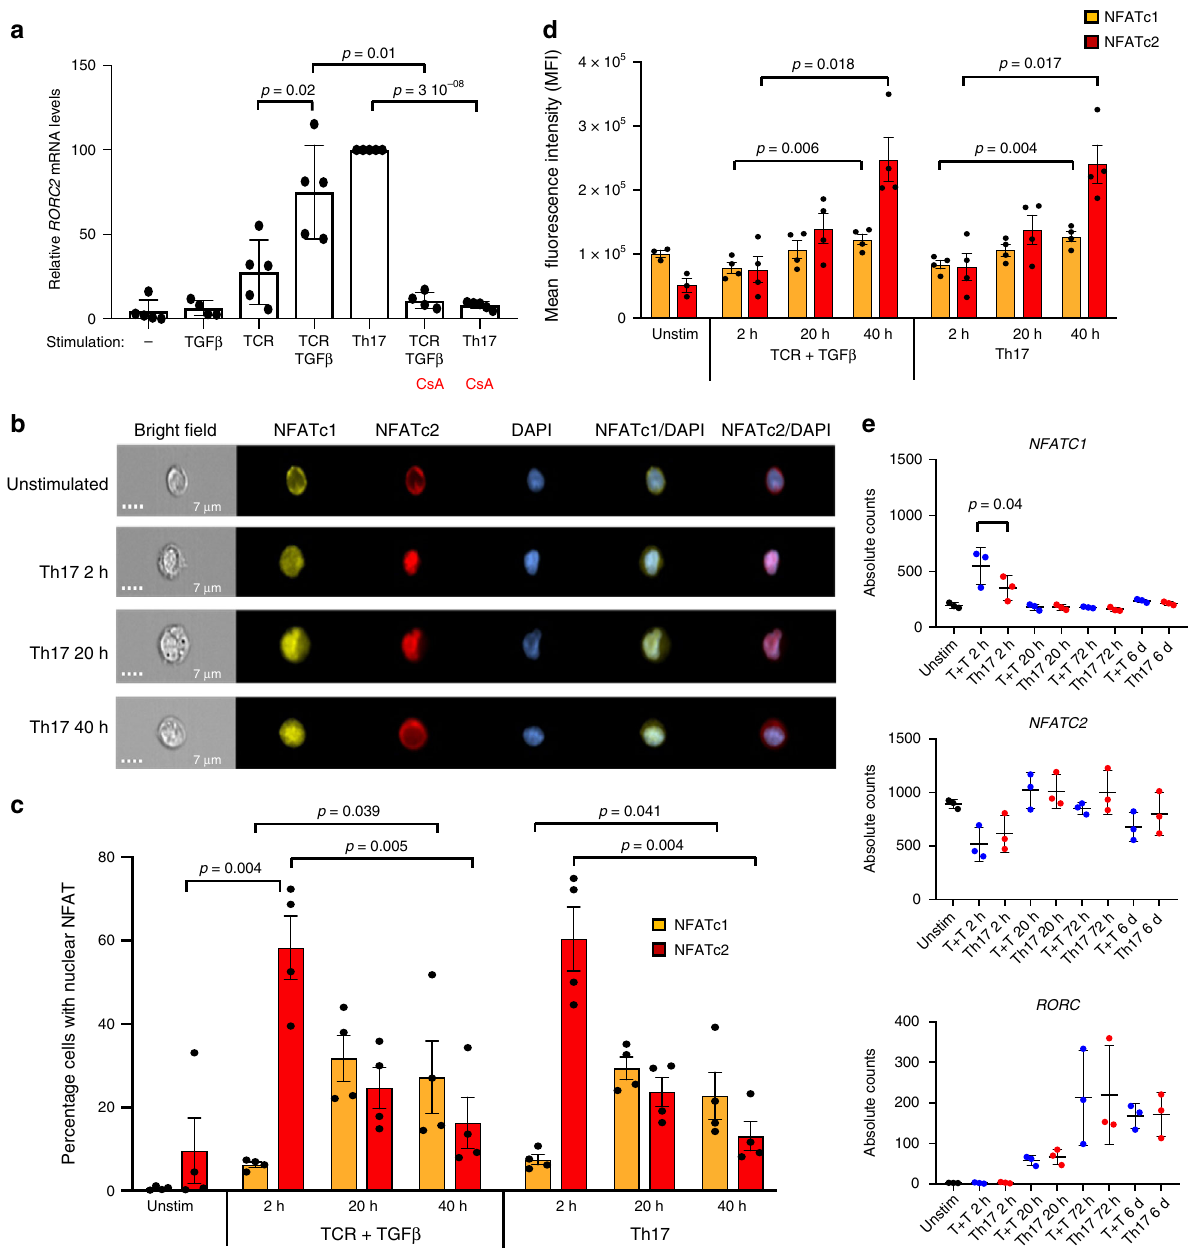
Fig. 4 NFAT/calcineurin regulates RORC 2 expression in peripheral CD4 + T cells. a RORC 2 expression is calcineurin-dependent. Cord blood CD4 + T lymphocytes were stimulated for 20 h. RORC 2 expression was quanti fi ed by RT-qPCR and represented as fold change relative to Th17 conditions. Average and SD of 5 experiments. b Cord blood CD4 + T cells were stimulated in Th17-inducing conditions for the indicated times, and the distribution of NFAT proteins was analyzed by Imaging Flow Cytometry. Representative images are shown for staining for NFATc1, NFATc2, DAPI, and the overlap of NFATc1 or NFATc2 with DAPI. Scale bar: 7 μ m. c The percentage of cells with nuclear NFAT translocation was calculated using a Similarity Score, and the average of 4 independent experiments was plotted for cells stimulated as shown. Bars indicate SEM. d The average mean fl uorescence intensity of the NFAT positive cells was plotted for the same samples analyzed in c . e Time-course analysis of absolute mRNA counts of NFAT and RORC measured by nCounter technology in stimulated cord blood CD4 + T cells. Shown are average and SEM from 4 independent experiments. p -values resulted from paired two-tailed t -test. “ − ” : unstimulated, CsA: Cyclosporine A, Unstim: unstimulated sample, T + T: TCR + TGF β , 6d: 6 days. Source data are provided as a Source Data